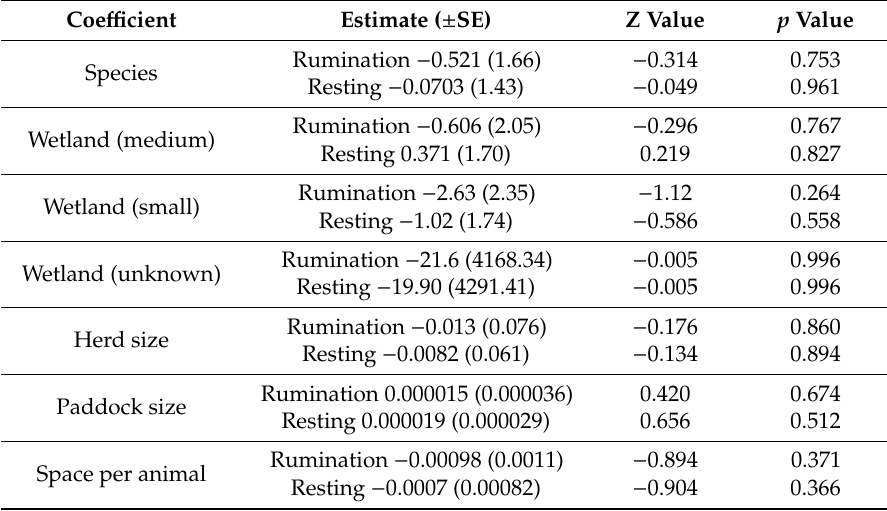
Table 5. Binomial GLM with logistic link output for predicting whether lechwe are seen resting or ruminating in wetland areas of their enclosure.